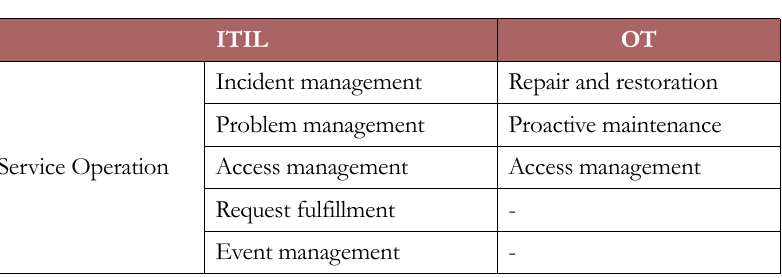
Table 6. High-level service operation ITIL - OT mapping